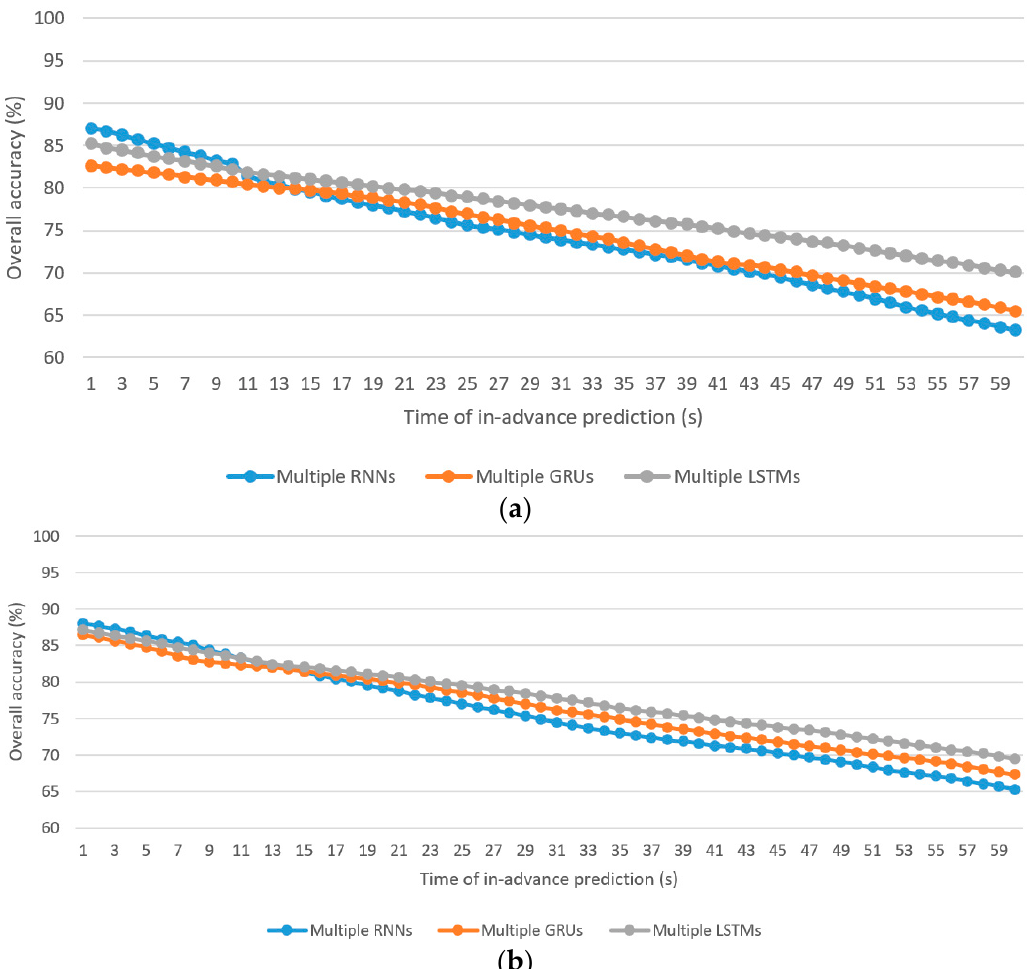
Figure 6. Overall accuracy of the prediction models based on boosting learning of multiple RNNs, GRUs, and LSTMs algorithms: ( a ) driver stress prediction; ( b ) driver drowsiness prediction. Table 3. Summary of the maximum and minimum OA all , OA class 1 , OA class 2 , and OA class 3 for the driver stress prediction and driver drowsiness prediction models based on boosting learning of multiple RNNs, GRUs, and LSTMs algorithms. Overall